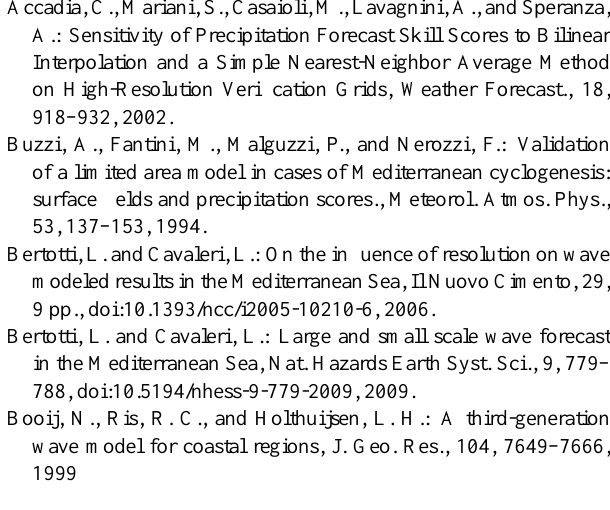
SWAN vs. buoy records. (b) comparison of T SWAN vs. buoy records. s p out of the regional grid. s